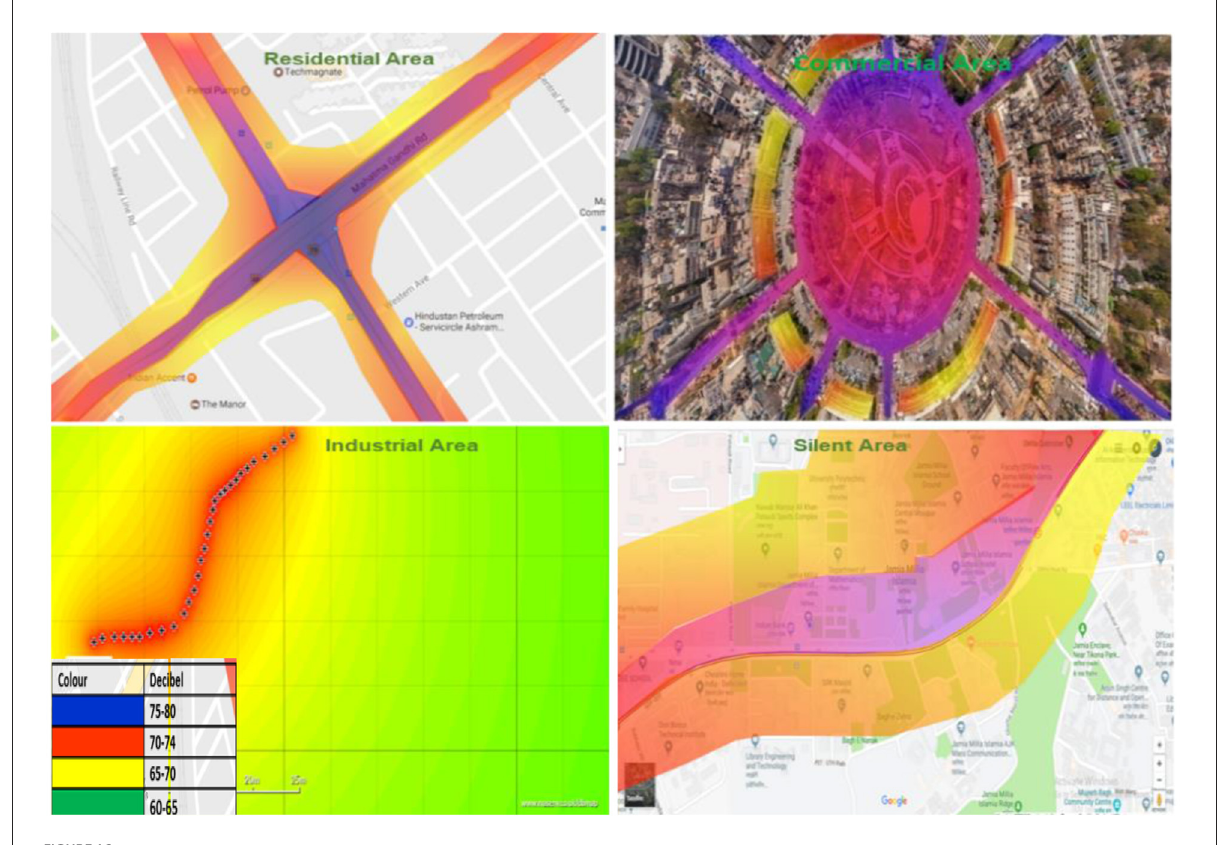
FIGURE16 Comparative analysis of noise level through 2D noise